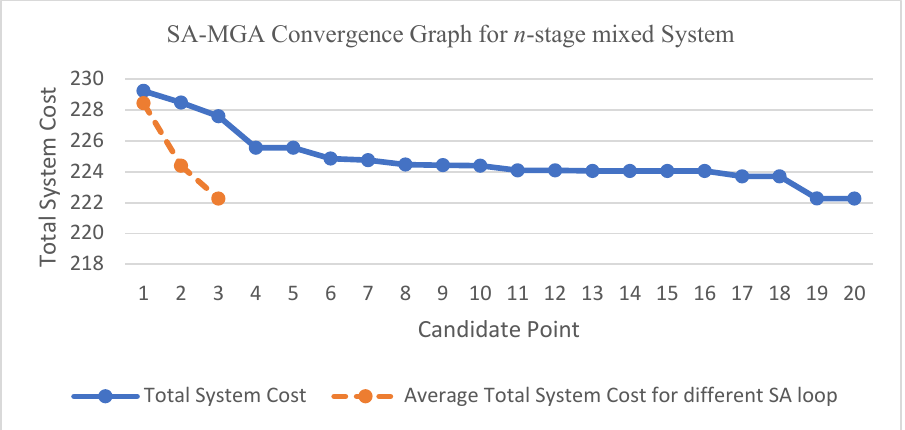
Figure 20. The convergence graph of the n -stage mixed system by utilizing the SA-MGA combined method.